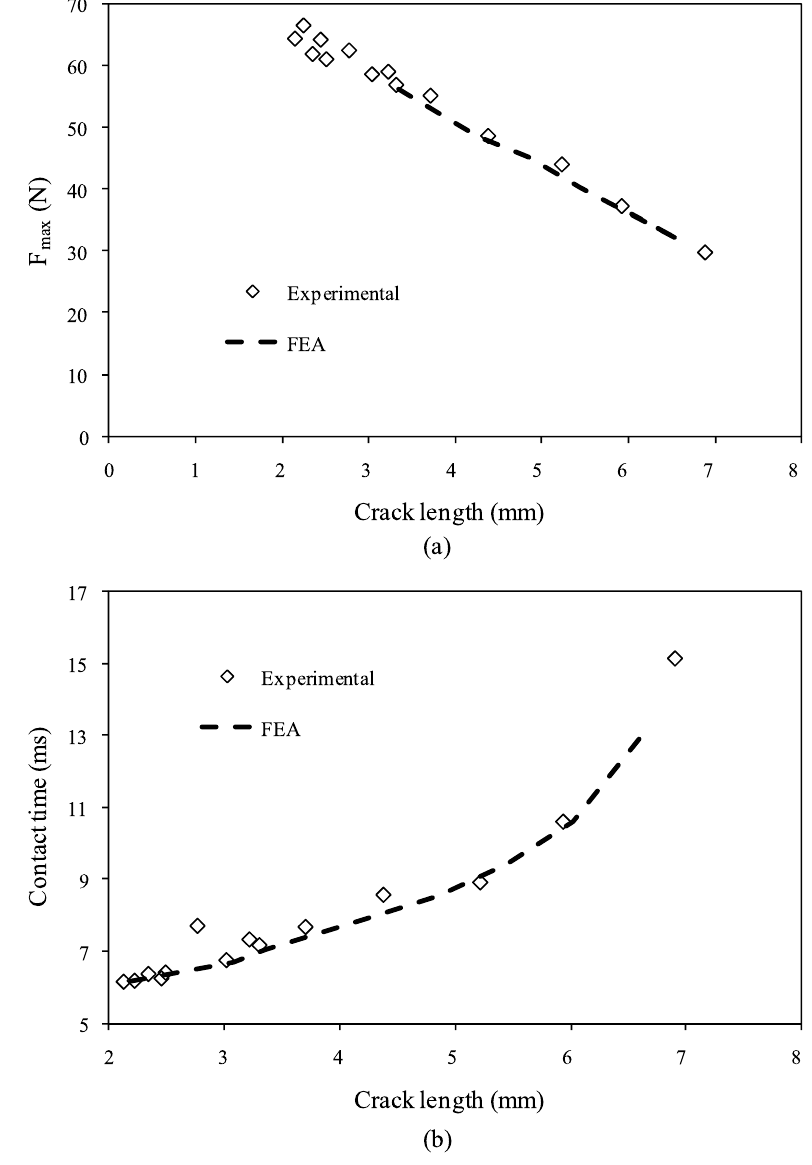
Fig. 10. Comparison of experimental and computed maximum force (a) and contact time (b) as functions of crack length. spring coupling was then introduced between the sample and a fixed base to represent the finite stiffness of the